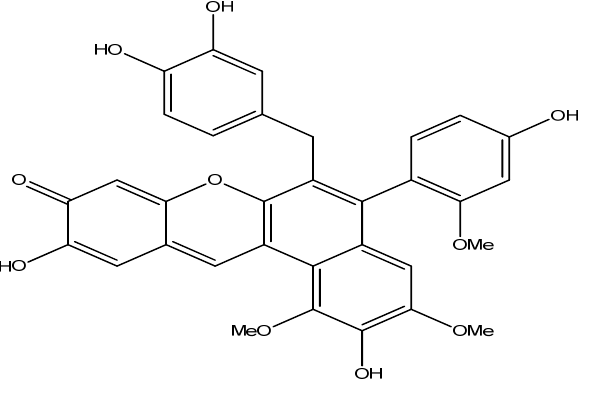
Figure 1. Santalin (CI Natural Red